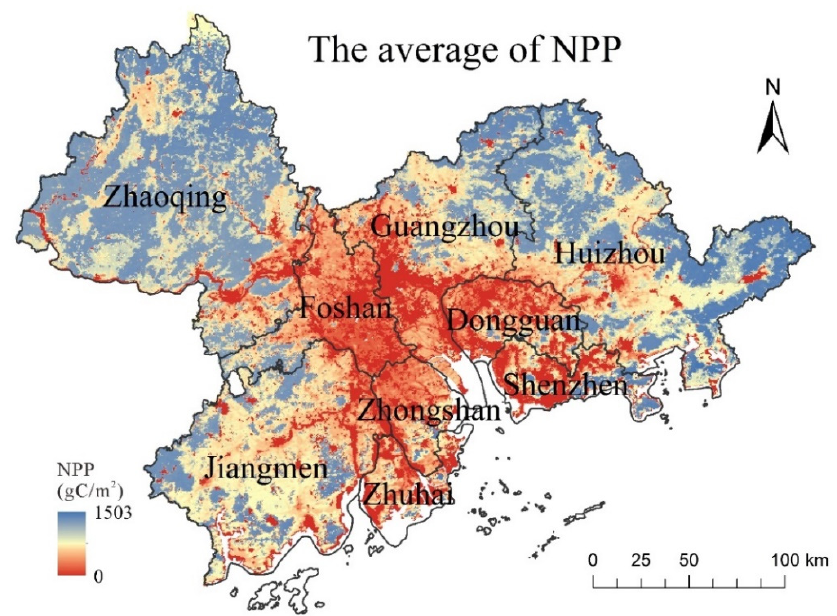
Figure 3. Average net primary productivity ( NPP ) of the Pearl River Delta (PRD) from 2000 to 2020.